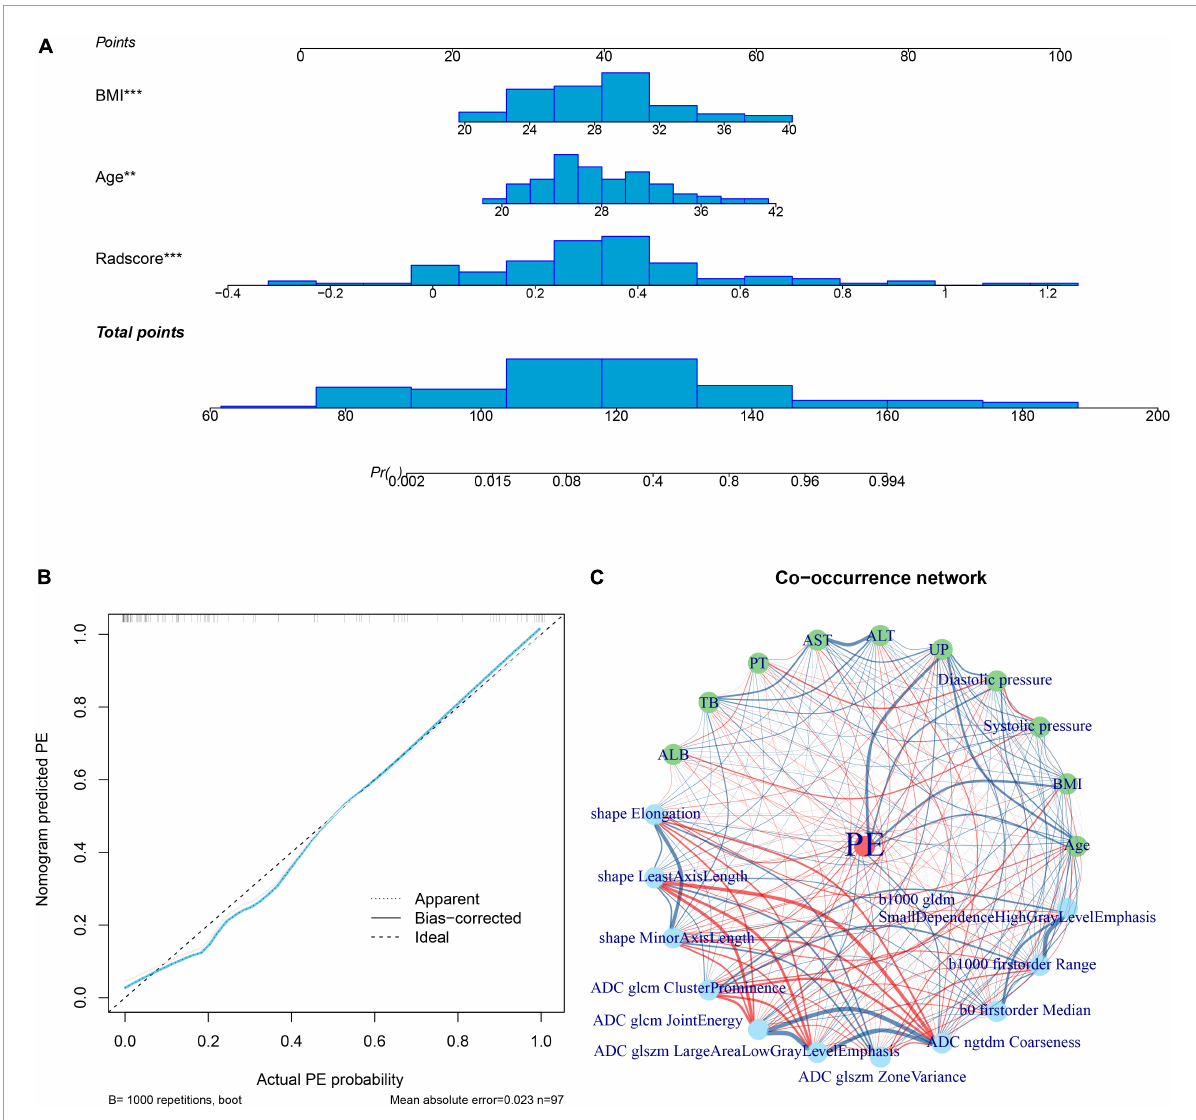
FIGURE4 Radiomics nomogram. The radiomics nomogram is developed by integrating rad-score with maternal age and body mass index in the training cohort; the distributions are shown on the nomogram lines (A) . The calibration curve shows the goodness of fit of the nomogram by the bootstrap test method (mean absolute error = 0.023) (B) . A co-occurrence network shows the correlations between radiomics signature and clinical risk factors of PE (C) . ALB, albumin; ALT, alanine aminotransferase; AST, aspartate aminotransferase; BMI, body mass index; PE, Pre-eclampsia; PT, prothrombin time; TB, total bilirubin; UP, 24 h urinary